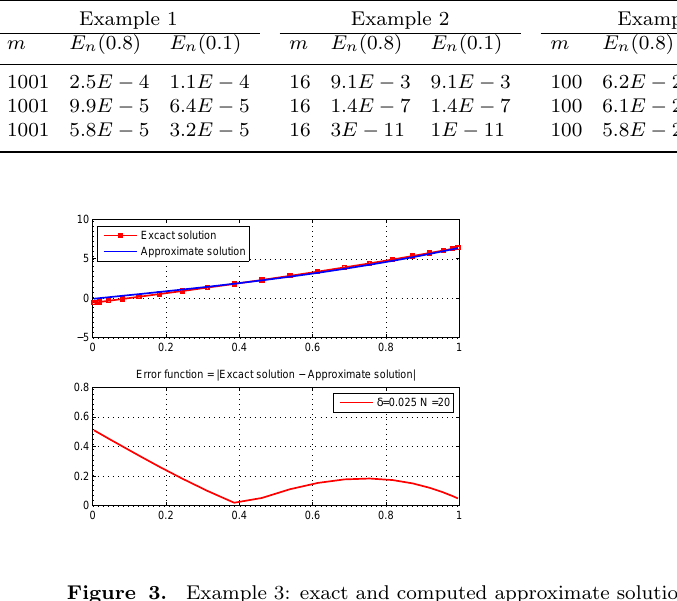
t 3 + 61 t − 43 . Moreover, x + = T ∗ Tz , z = 1, 12 10 72